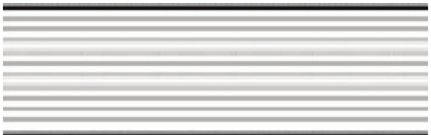
Figure 1: Cross-sectional area of the sample with full of line of fluxes.